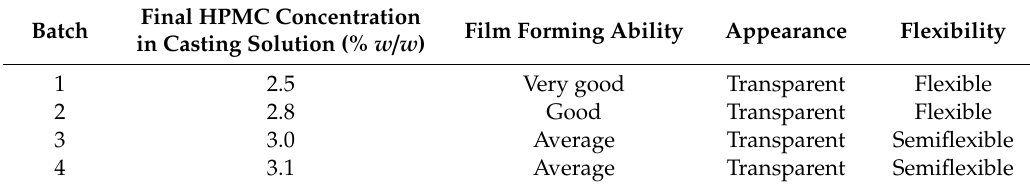
Table 2. Film forming ability, transparency, and flexibility of the studied blank films. Batch